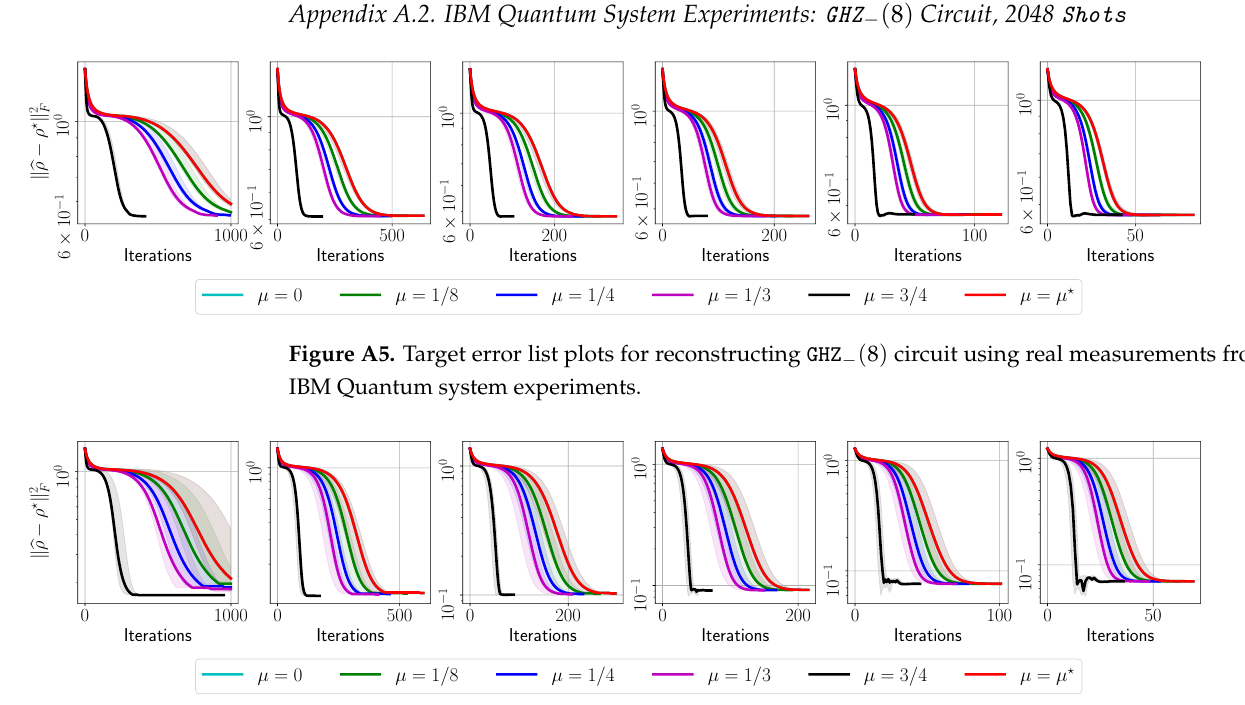
Figure A4. Fidelity list plots for reconstructing GHZ IBM Quantum system experiments and synthetic measurements from Qiskit simulation experiments.